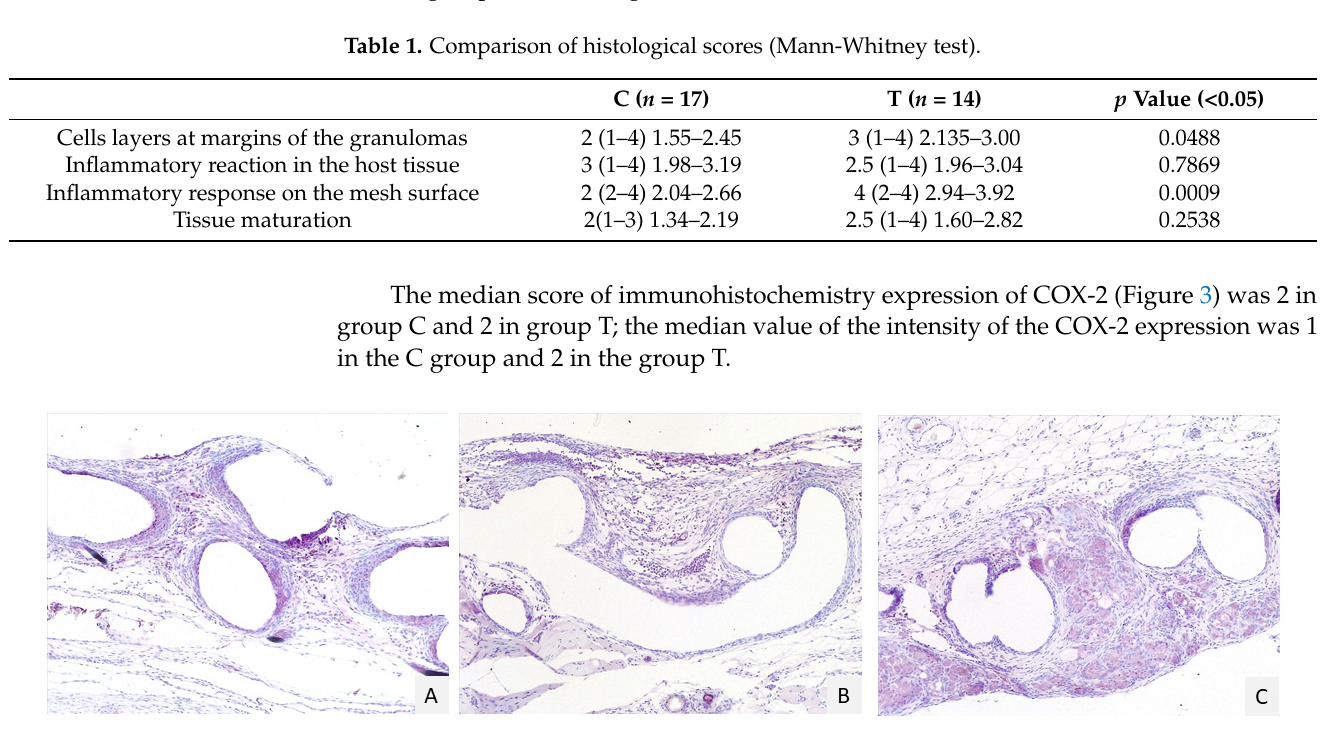
Table 1. Comparison of histological scores (Mann-Whitney test).